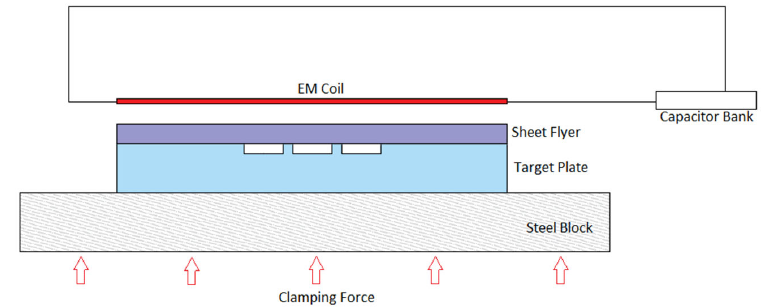
Figure 3. Experimental arrangement for the electromagnetic joining process.